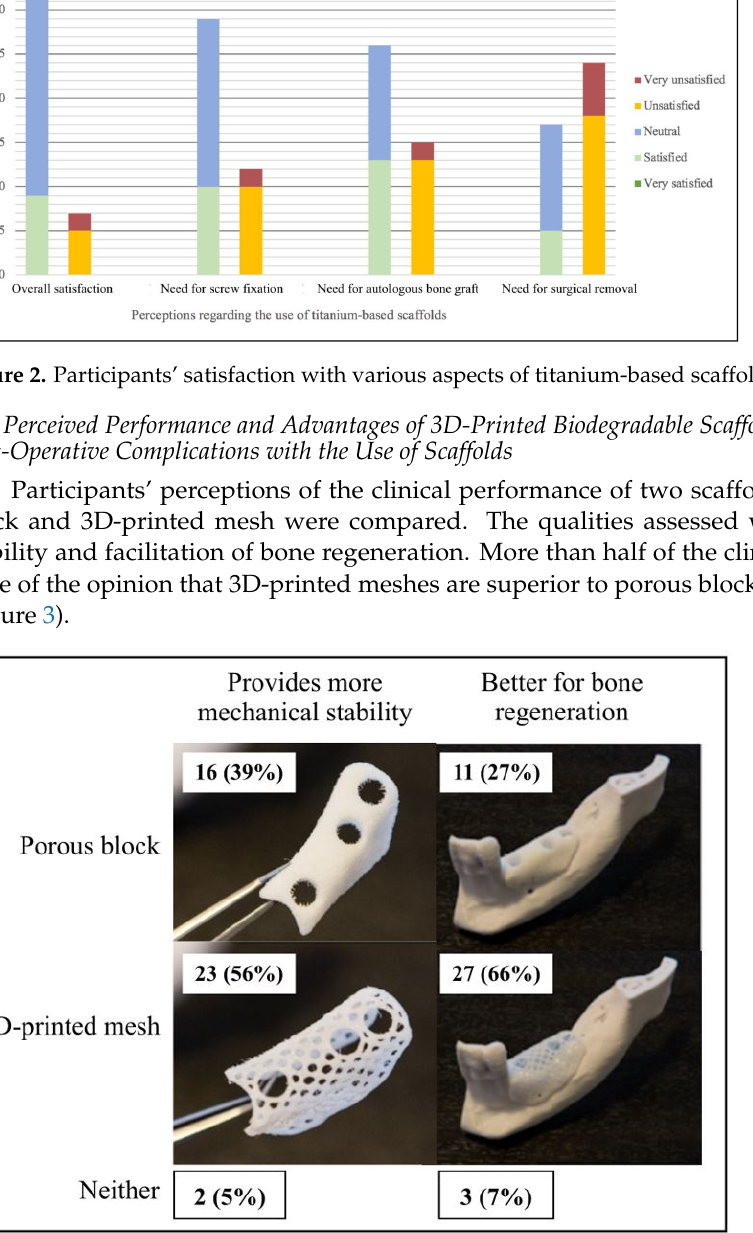
Figure 3. Comparison of clinical performance between the porous block and 3D-printed mesh.